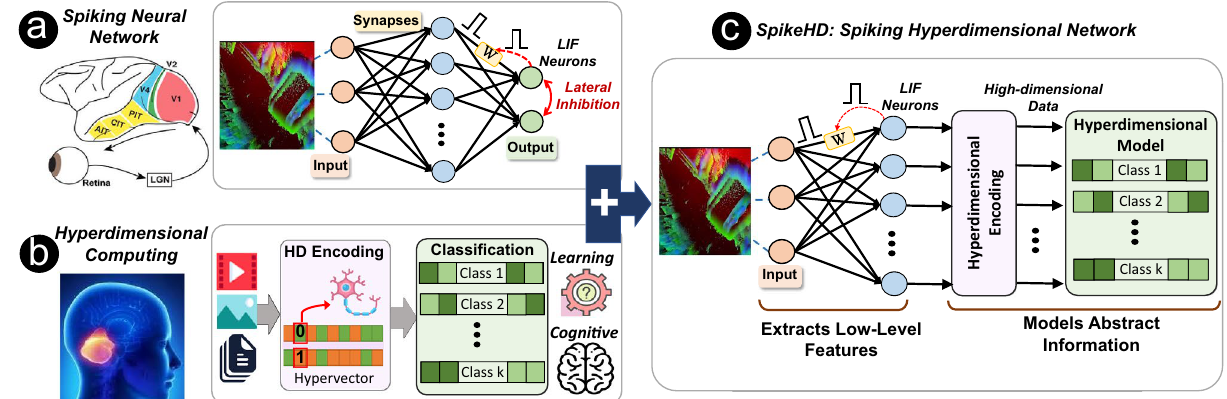
Figure 1. SpikeHD overview architecture: ( a ) spiking hyperdimensional neural network (Reprinted with permission from reference 85 . Copyright 2012 Elsevier); The leaky-integrate-and-fire (LIF) layers of the SNN have a high synaptic resemblance to the neuronal systems in the brain. This gives rise to its advantage in (the learning of) sensory data processing and maintaining working memory for classification. ( b ) The high- dimensionality and holography of HDC renders a cerebellum-like functionality with a high capacity memory. ( c ) the combination of the two as guided by the Atkinson-Shiffrin memory model allows SpikeHD to take advantage of both and overcome their respective